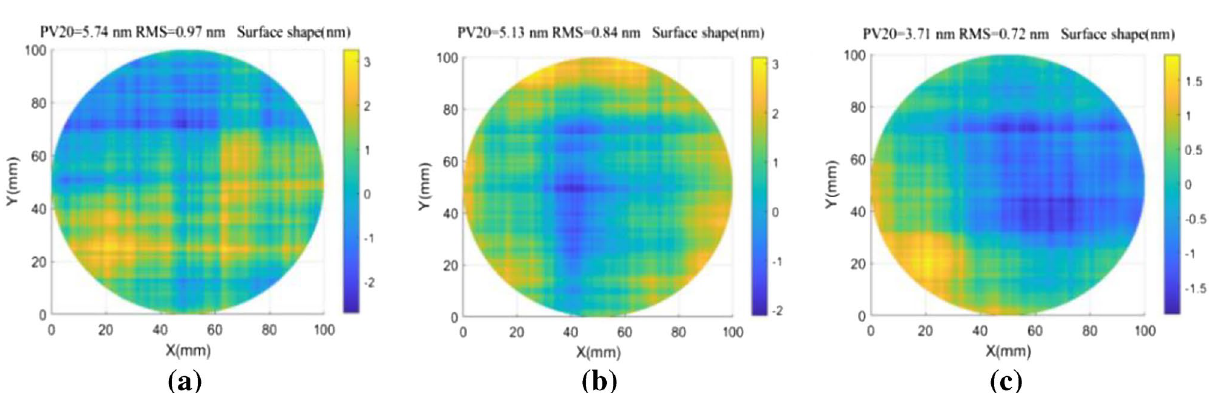
Figure 3. The residual shape of measured surfaces corresponding to different frequency spectrum compensation methods. ( a ) Direct zero filling. ( b ) Average neighboring points. ( c ) Conjugate double